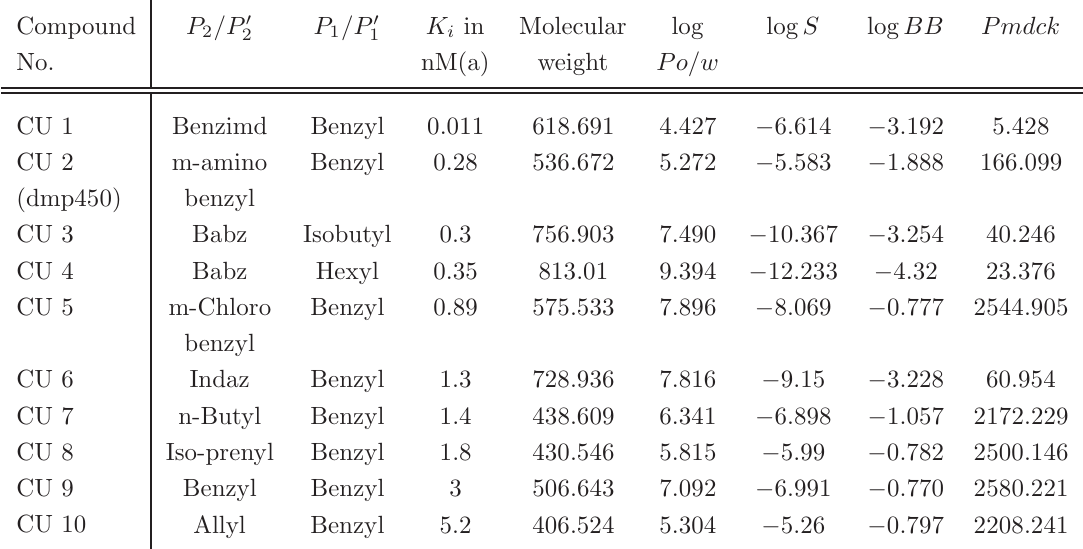
Table 1 ADME properties of cyclic urea inhibitors.